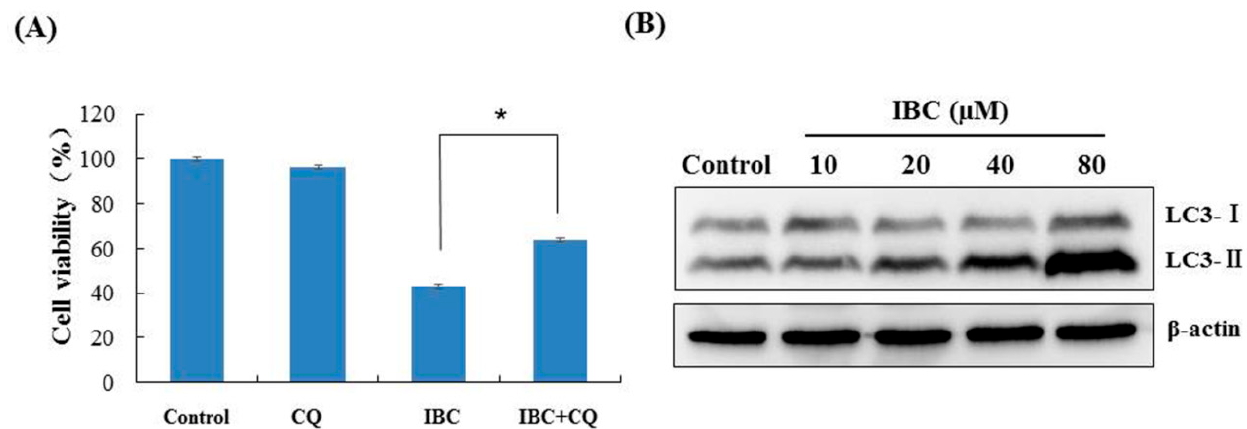
Figure 8. IBC induced autophagy in MDA-MB-231 cells. ( A ) Cell viability following treatment with IBC (40 µM) for 24 h with or without pre-treatment with the autophagy inhibitor CQ (20 µM) as measured by the MTT assay. ( B ) The expression of LC3 protein levels was analyzed by Western blotting. * p < 0.05 compared between the groups of IBC and IBC with CQ.